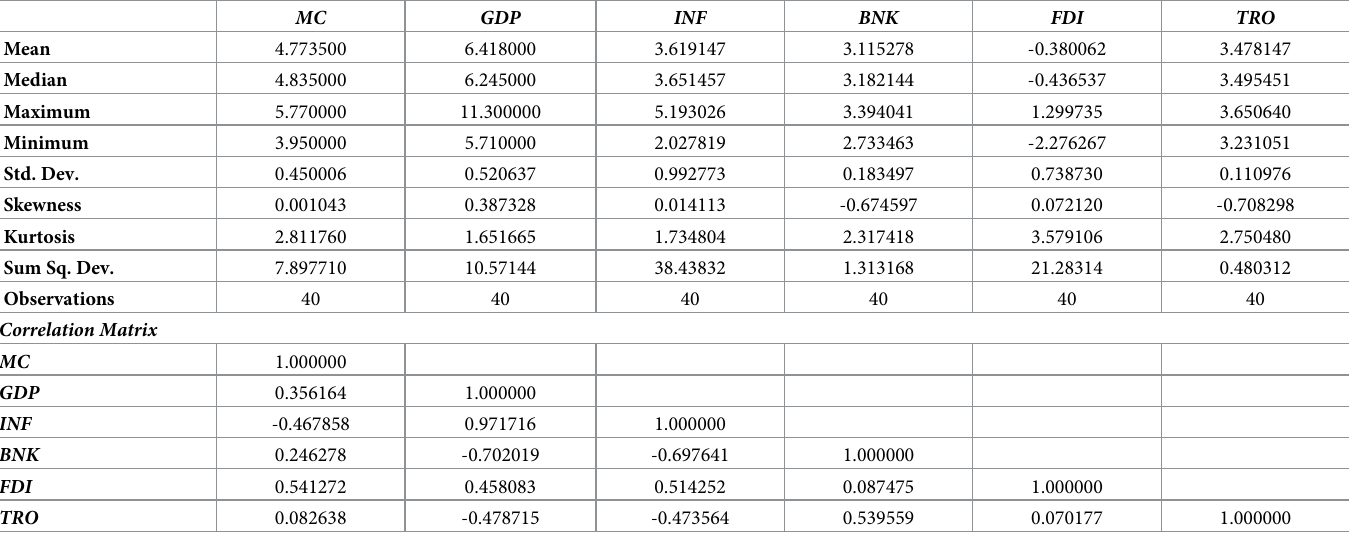
Table 1. Descriptive statistics and correlation matrix of the